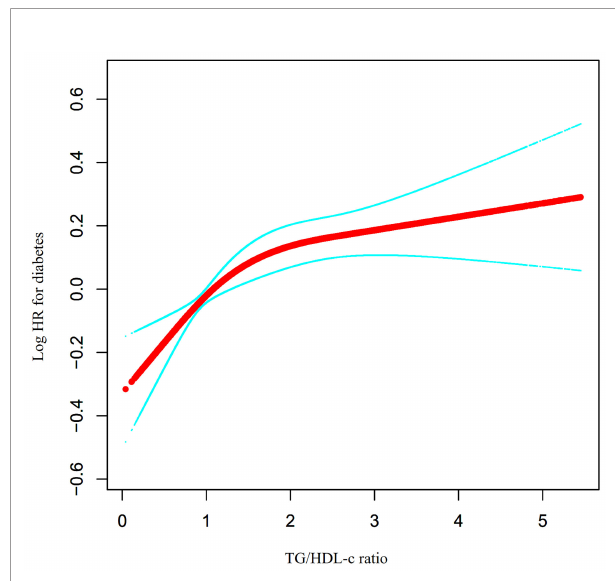
FIGURE 6 | The non-linear relationship between TG/HDL-c ratio and the risk of diabetes in prediabetic participants. We used a Cox proportional hazards regression model with cubic spline functions to evaluate the relationship between TG/HDL-c ratio and diabetes risk. The result showed that the relationship between the TG/HDL-c ratio and diabetes risk in prediabetic patients was non-linear, with the in fl ection point of TG/HDL-c ratio being 1.415.